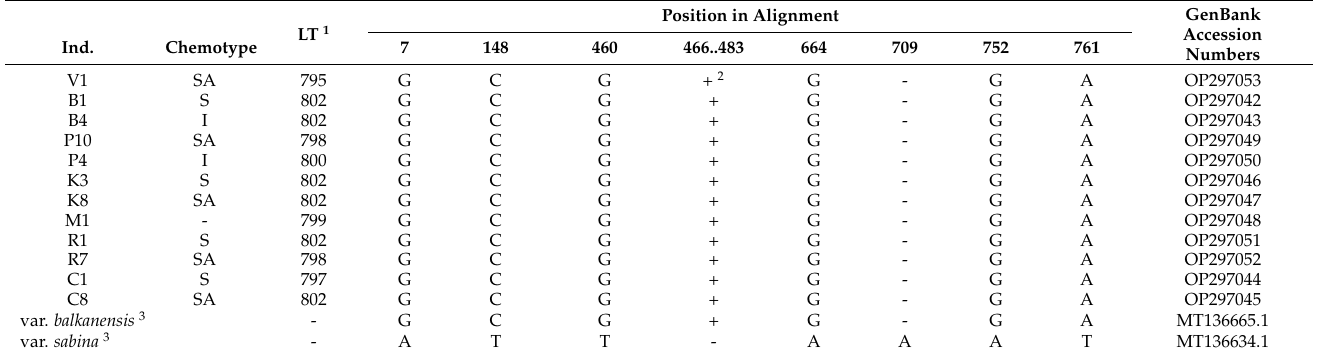
Table 3. SNPs and indels in chloropast trn G- trn S intergenetic spacer of Juniperus sabina var. balkanensis